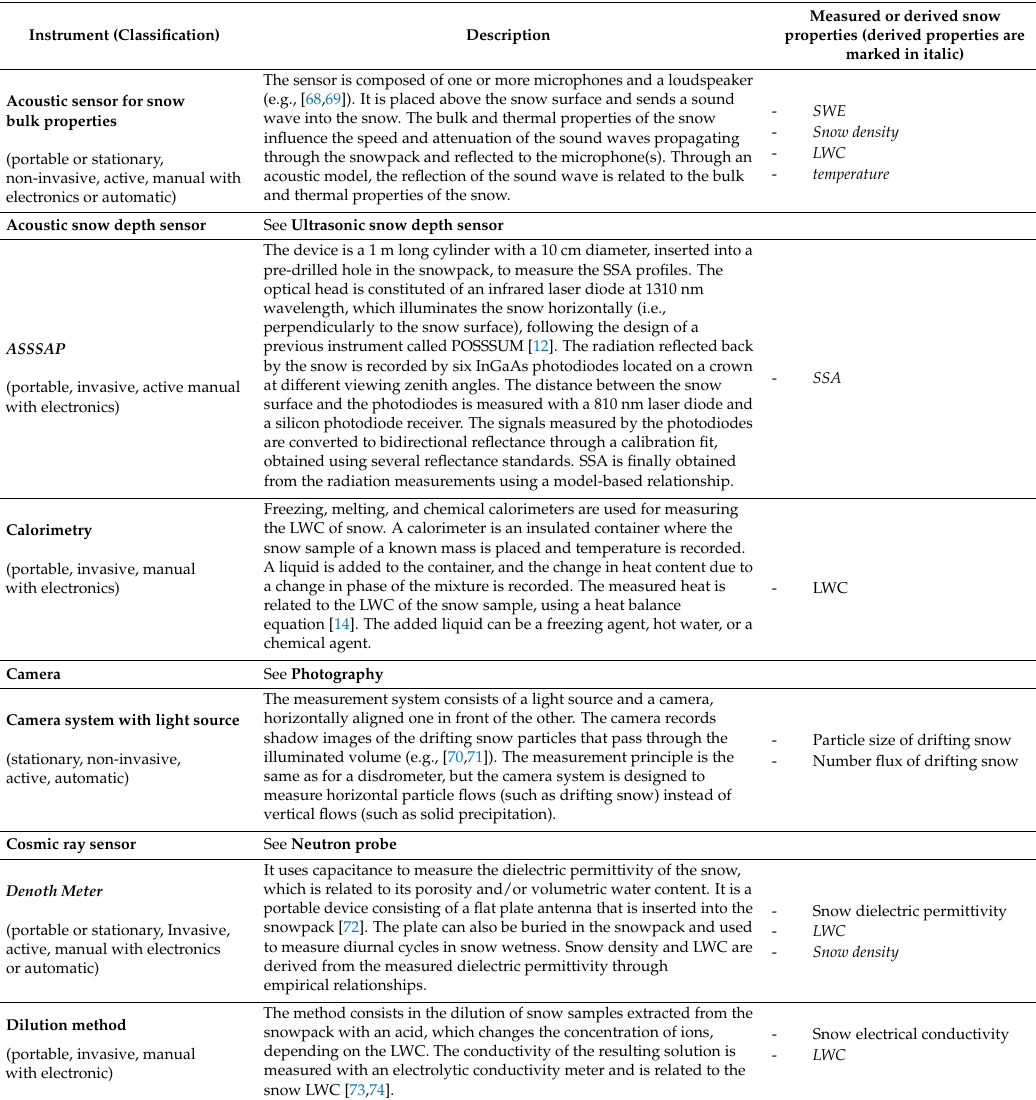
Table A6. List of instruments, in alphabetic